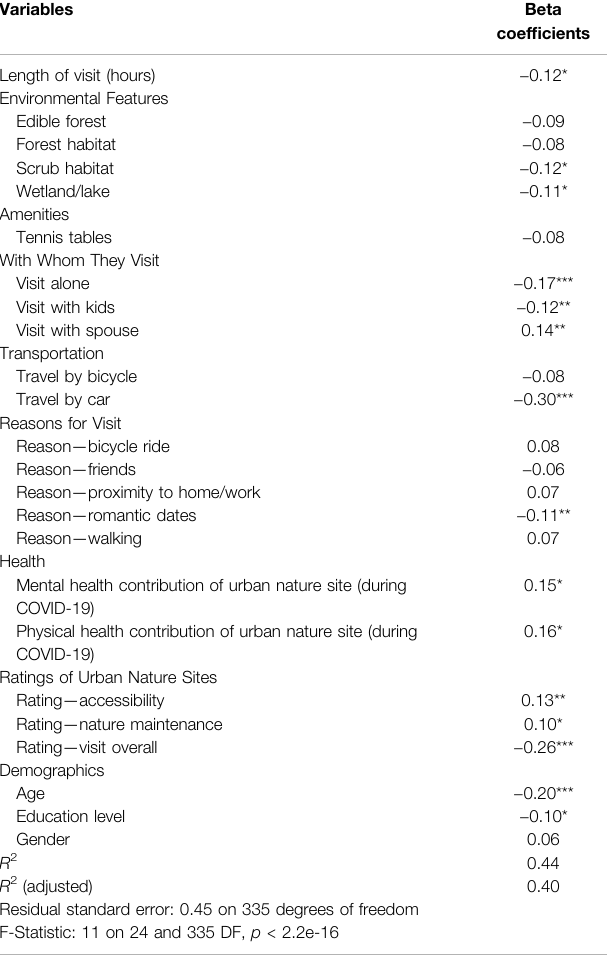
TABLE 5 | Multiple linear regression model results for the visitation frequency relative change